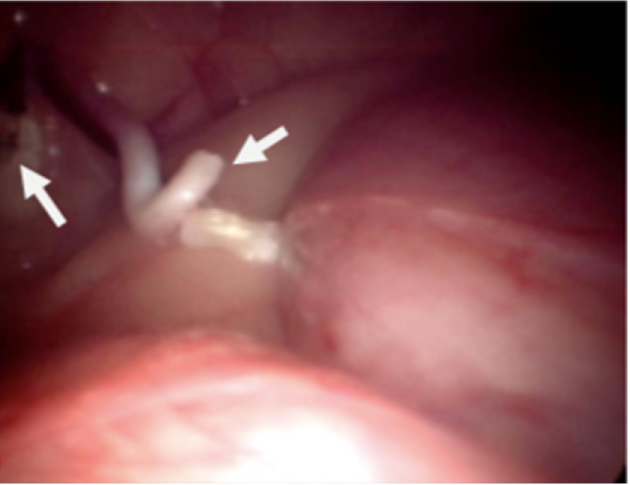
Figure 4. Image of the laparoscopic surgery to confirm that both structures were cut, and without the presence of active hemorrhage.